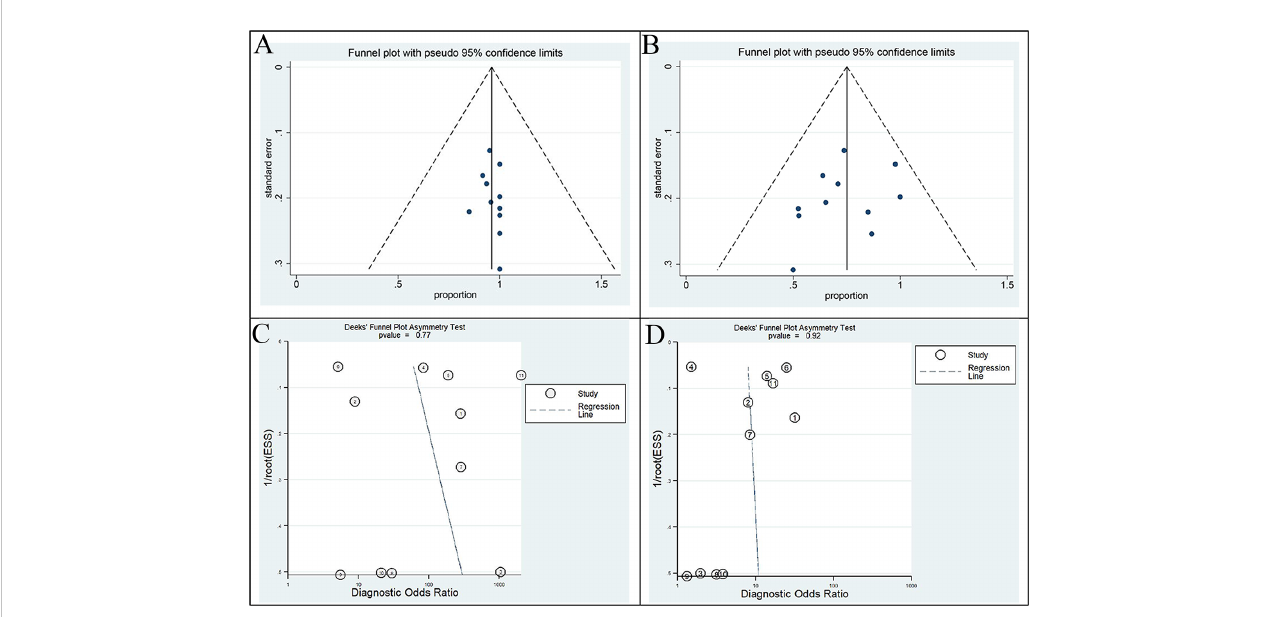
FIGURE 5 Funnel plot of this meta-analysis. Funnel plots with Egger ’ s test for 68 Ga-FAPI (A) and 18 F-FDG PET/CT (B) in primary tumor staging (all p>0.05). Funnel plots with Deek ’ s test for 68 Ga-FAPI (C) and 18 F-FDG PET/CT (D) in non-primary tumour (all p>0.05). All of these results indicate the absence of a publication